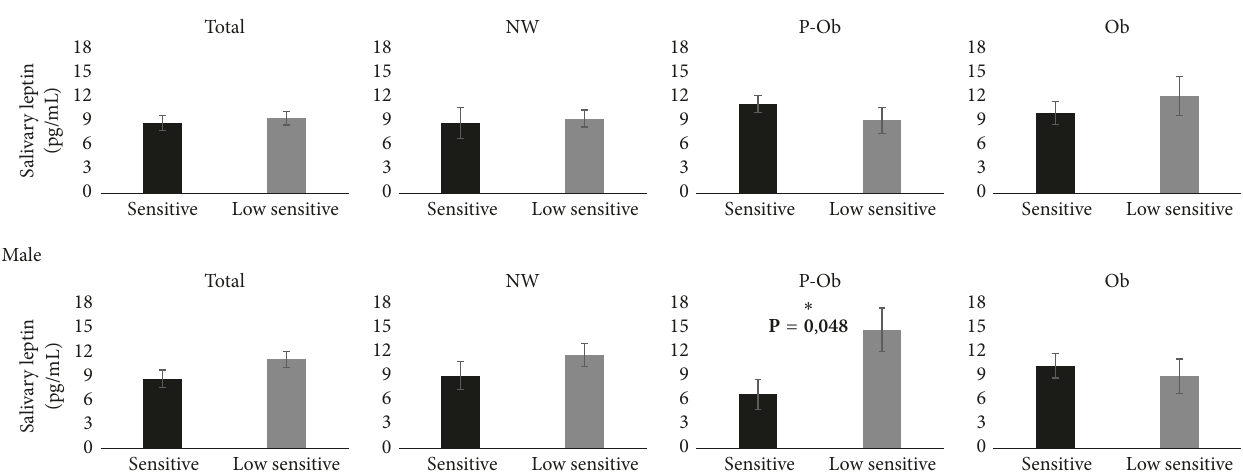
Figure 4: Salivary leptin levels in children with different bitter taste sensitivity (NW – normal weight; P-Ob: preobese; Ob: obese). [NW: normal weight ( 𝑁 = 28 girls and 31 boys; P-Ob: preobese 𝑁 = 16 girls and 13 boys); Ob: obese ( 𝑁 = 13 girls and 13